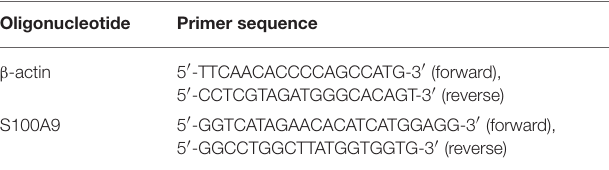
TABLE 1 | Oligonucleotide and primer